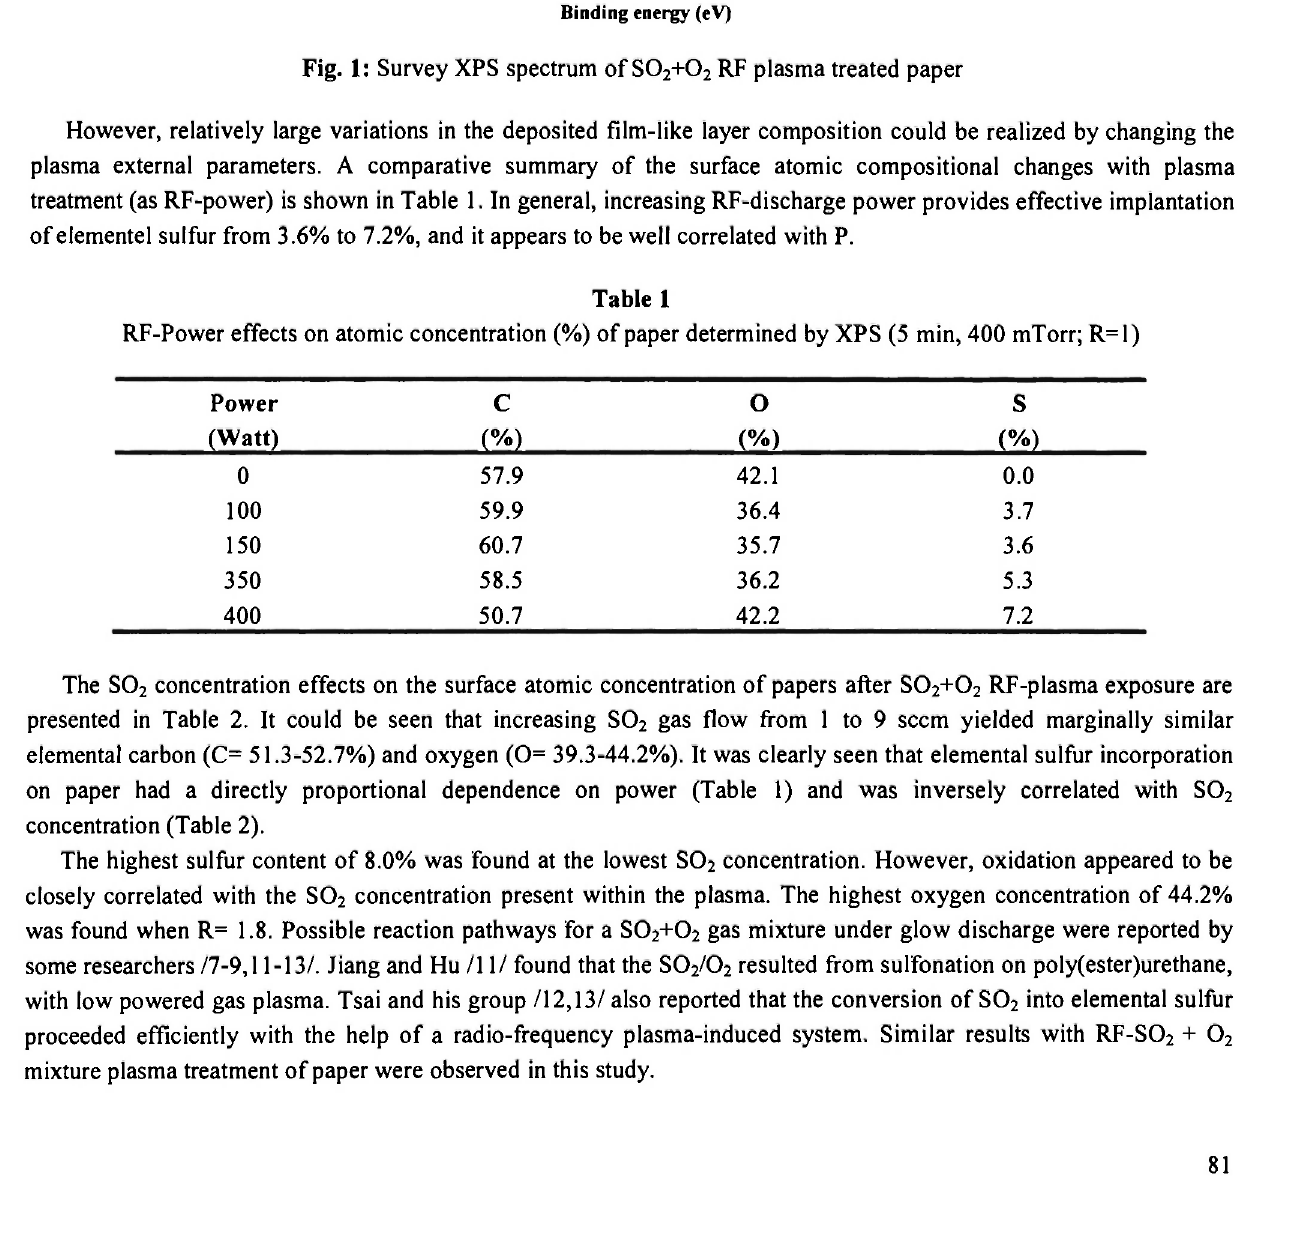
Fig. 1: Survey XPS spectrum of S0 2 +0 2 RF plasma treated